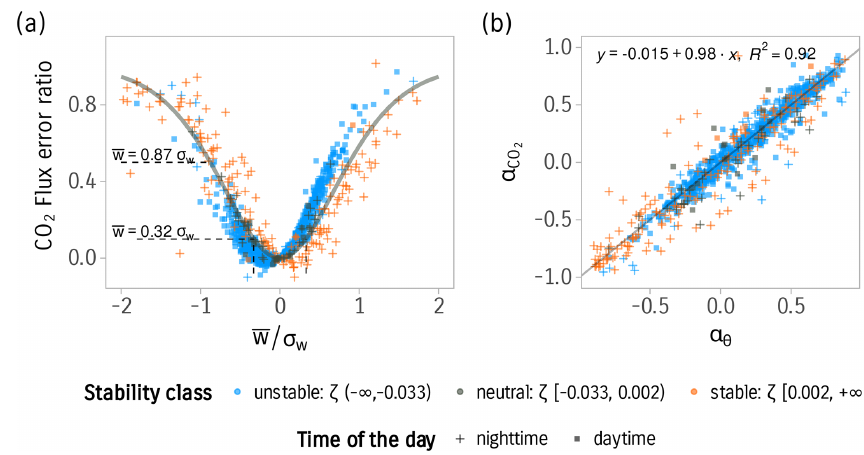
Figure 3. (a) The error ratio in the CO 2 flux calculated using the TEA method due to nonzero mean vertical wind. The solid gray line repre- sents the analytical values of the error in the flux (if a joint Gaussian probability distribution is assumed). The points are the observed error calculated from high-frequency measurements colored according to stability classes. The point shape distinguishes daytime and nighttime data. (b) Relation of α CO calculated for CO 2 and α θ calculated from sonic temperature along with a 1-to-1 line for 2